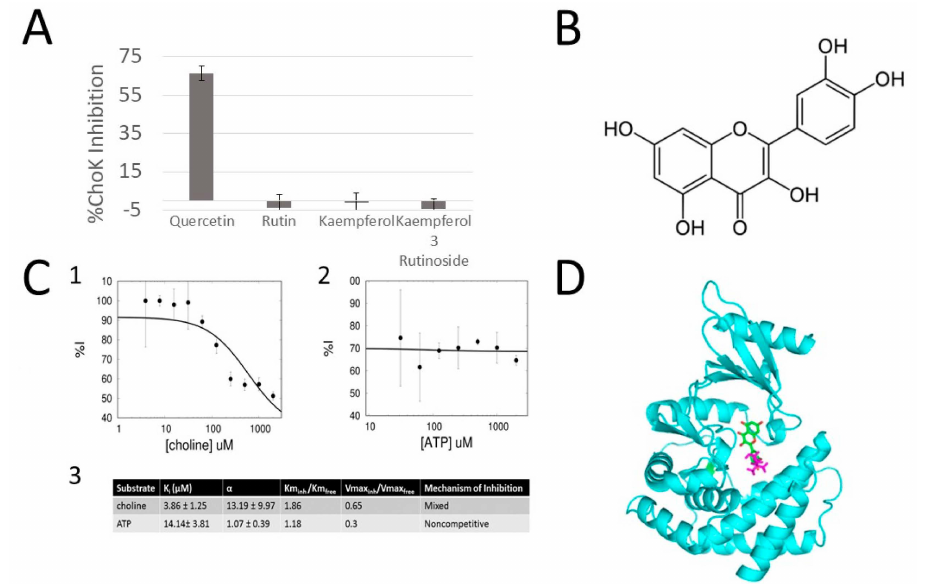
Figure 2. ( A ) Choline kinase enzymatic assays, in which the % inhibition of choline kinase is measured in the presence of 100 µ M of several flavonoids. As seen in the figure, one flavanoid has a highly inhibitory effect against choline kinase while a few related flavonoids do not. ( B ) The chemical structure of the most potent flavonoid identified ( C ) kinetic study of quercetin versus ATP and choline substrates: ( 1 ) inhibition analysis of quercetin in competition with choline. ( 2 ) Inhibition analysis of quercetin in competition with ATP. ( 3 ) Kinetic constants demonstrating the mechanism of inhibition of quercetin versus choline and ATP, an α > 1 indicates competitive behavior, an alpha = ~1 is indicative of non-competitive behavior. Likewise, a Km(inh)/Km(free) > 1 is indicative of the competitive behavior of quercetin with respect to choline ( D ) Docking model of binding of quercetin (green) to the choline binding site of choline kinase (cyan). The choline molecule is shown in